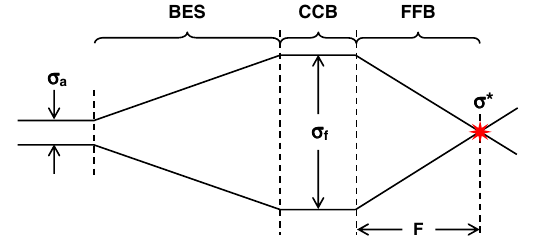
FIG. 1. Schematic IR layout consisting of beam expansion section (BES), chromaticity compensation block (CCB), and final focusing block